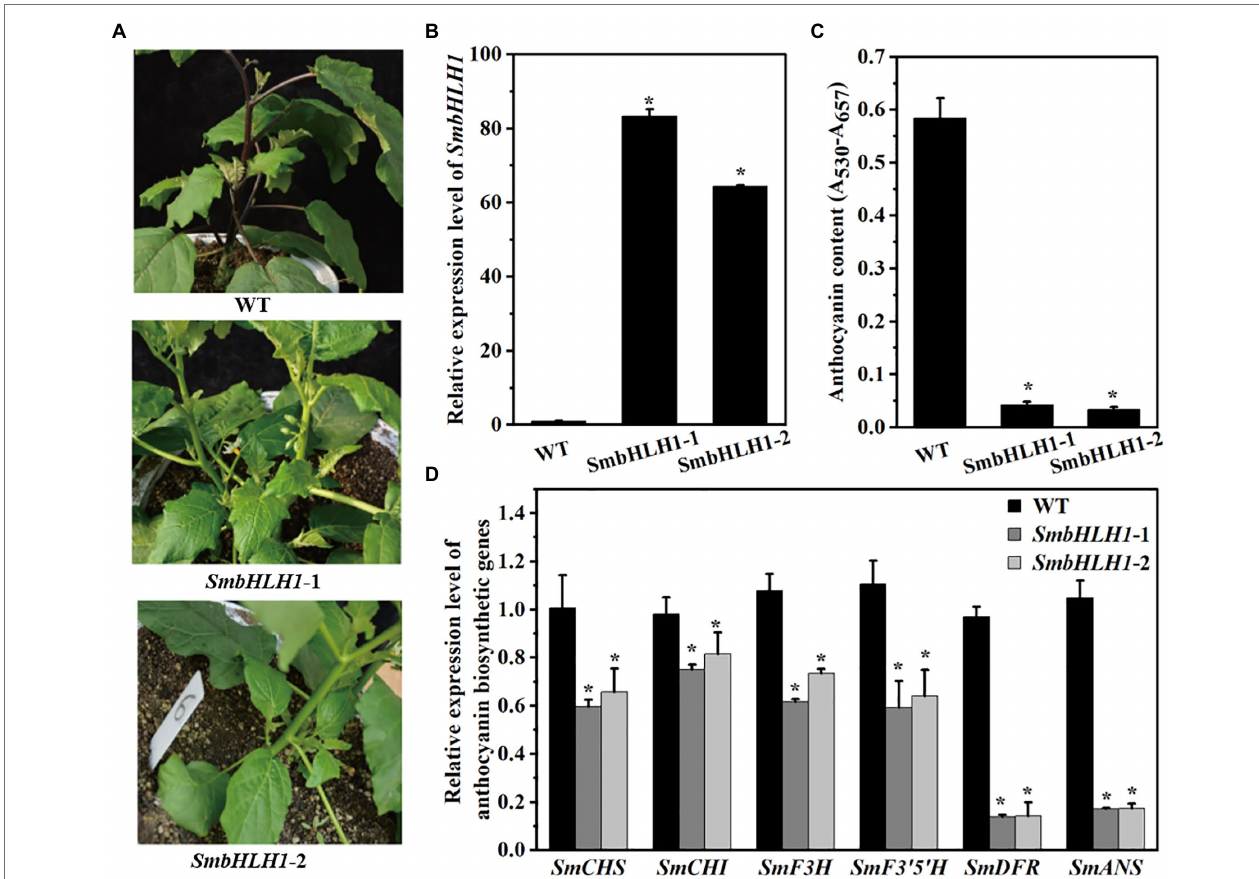
FIGURE 3 | SmbHLH1 controls anthocyanin biosynthesis in the stem peels of eggplant (cultivar No. 109). (A) The phenotypes of WT and the two SmbHLH1 transgenic lines ( SmbHLH -1 and -2); (B) The relative expression level of SmbHLH1 in the two 35S:: SmbHLH1 stem peels lines; (C) The anthocyanin content in the two 35S:: SmbHLH1 stem peels lines; and (D) The relative expression level of anthocyanin biosynthetic genes in stem peels of the two 35S:: SmbHLH1 lines. Values are means ± SD ( n = 3). * represents significance at p < 0.05 comparing with wild-type